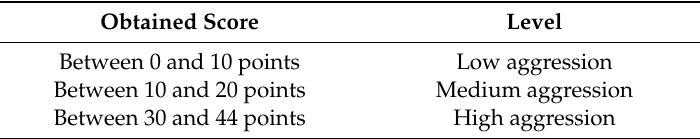
Table 2. Scale of aggression and conflict in the classroom by